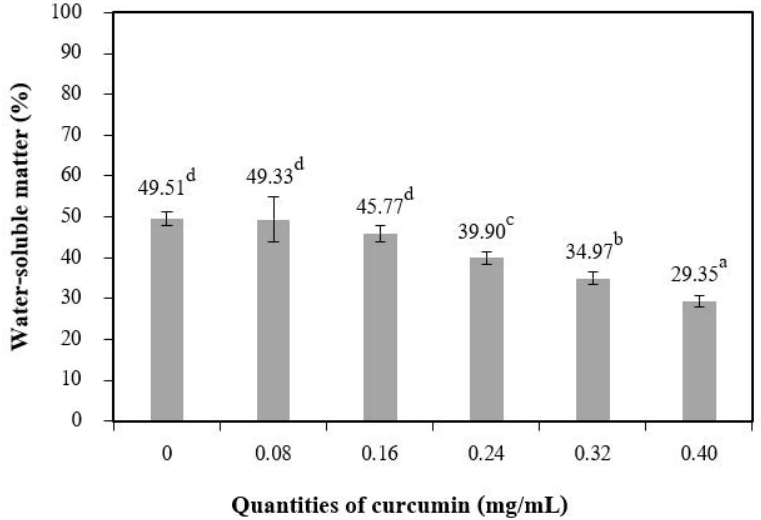
Figure 5. The water-soluble matter of chitosan film incorporated with various curcumin quantities. Results marked with different letters are statistically different ( p < 0.05).